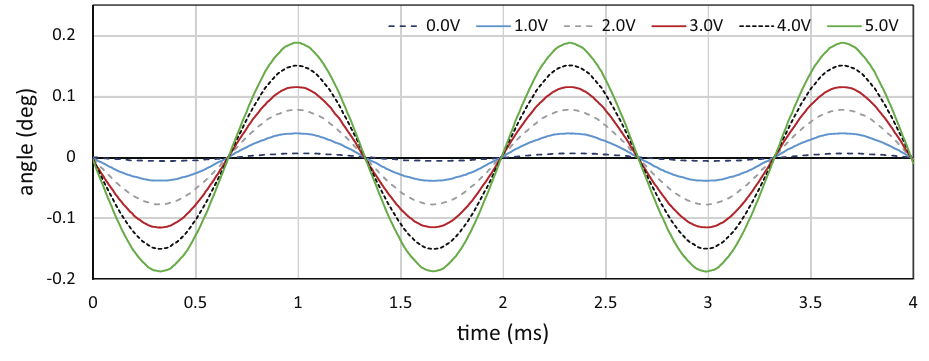
Figure 8. Relationship between drive voltage and angular displacement.